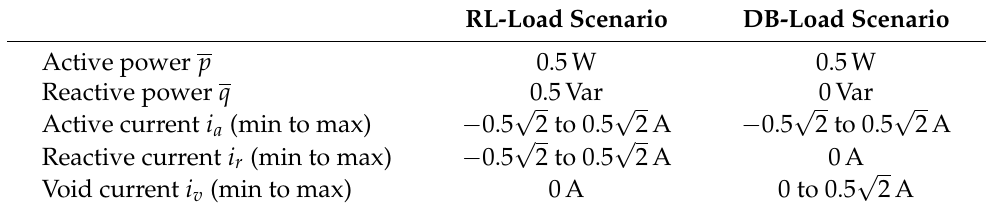
Table 2. Expected pre-disturbance steady-state measurements for the RL-load and DB-load